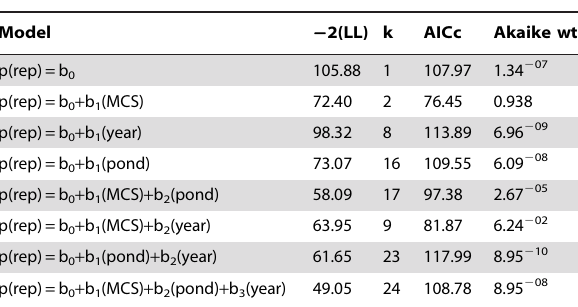
Table 2. Models evaluated, 2 2 log likelihood [ 2 2(LL)], k, Akaike information criterion corrected for small sample size (AICc), and Akaike weights used in model fitting procedure testing chorus size effects on observed reproduction (rep) for the Houston toad ( Bufo houstonensis